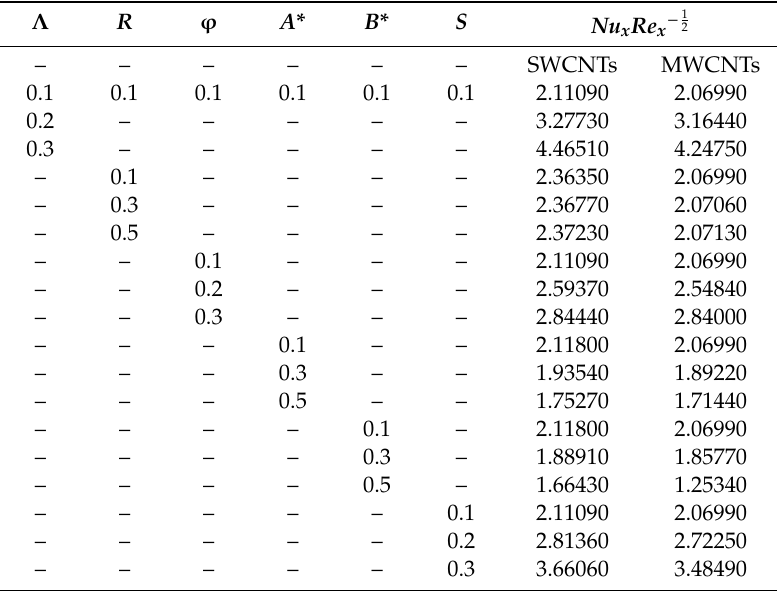
Table 5. The numerical value of the Nusselt number with γ = 0.1, P r =